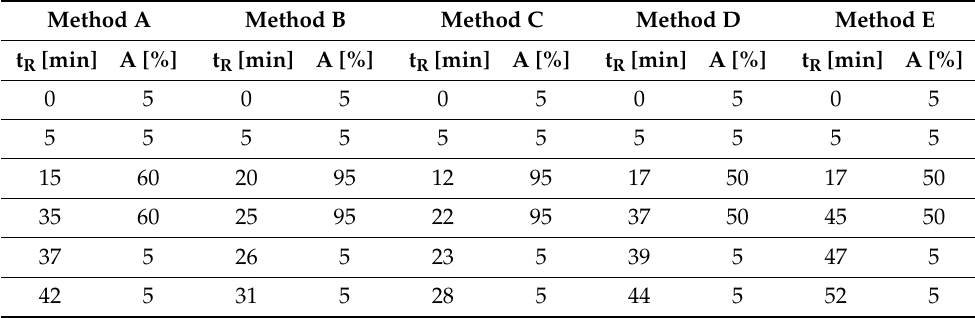
Table 5. UHPLC and preparative HPLC